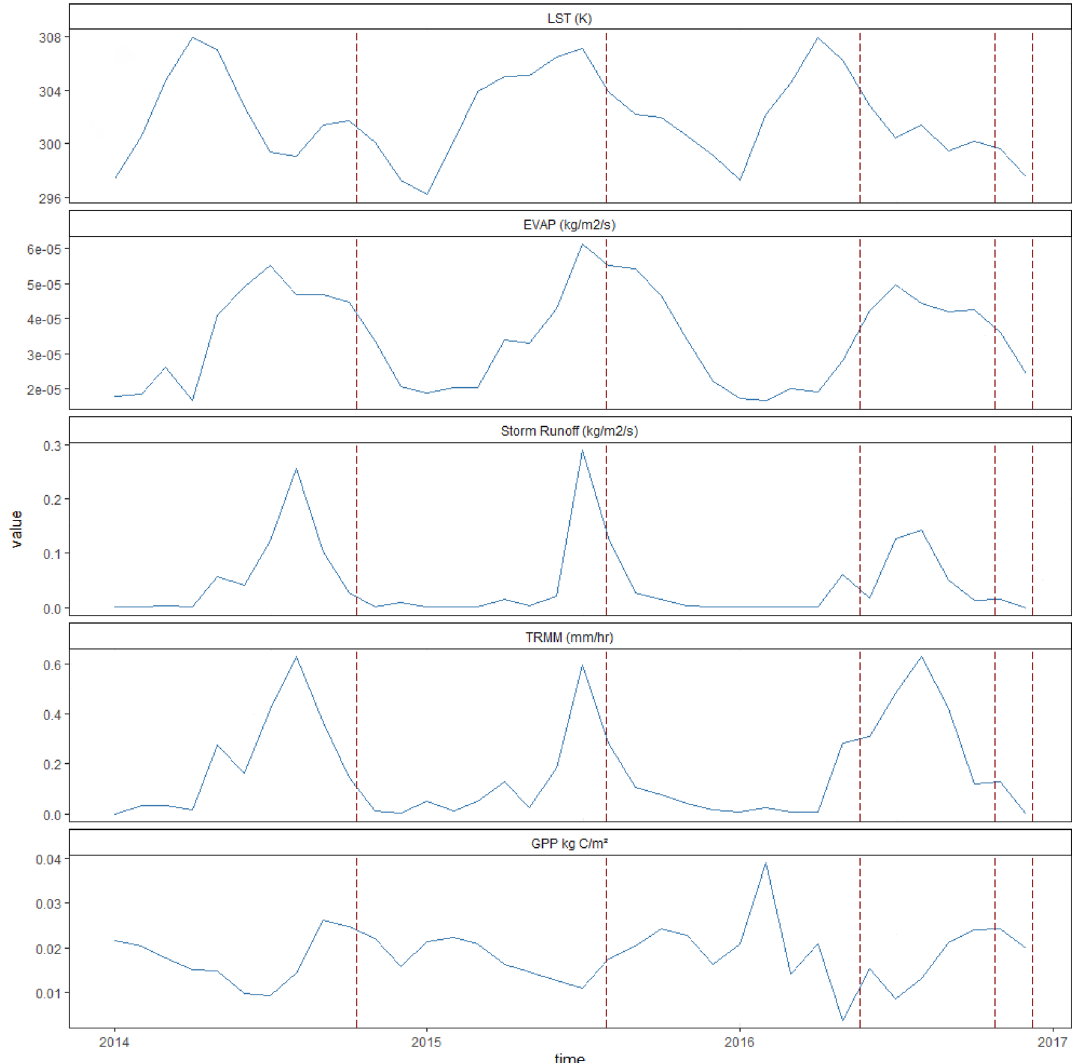
Figure 5. Time series, area-averaged monthly values for Land surface temperature (LST), Evapotranspiration (EVAP), Storm surface runoff, Precipitation Rate (TRMM), and Enhanced vegetation index (EVI) for pixels between Region 86.9014E, 20.6029 N, 87.0511E, 20.8007 N. LST data were obtained from MODIS-Terra MOD11C3 at 0.05 deg, EVAP data and Storm surface runoff values are model outputs of GLDAS-NOAH025 at 0.25 deg, precipitation rate data are from TRMM at 0.25 deg, and EVI values at 0.05 deg from MODIS-terra MOD13C2 satellite